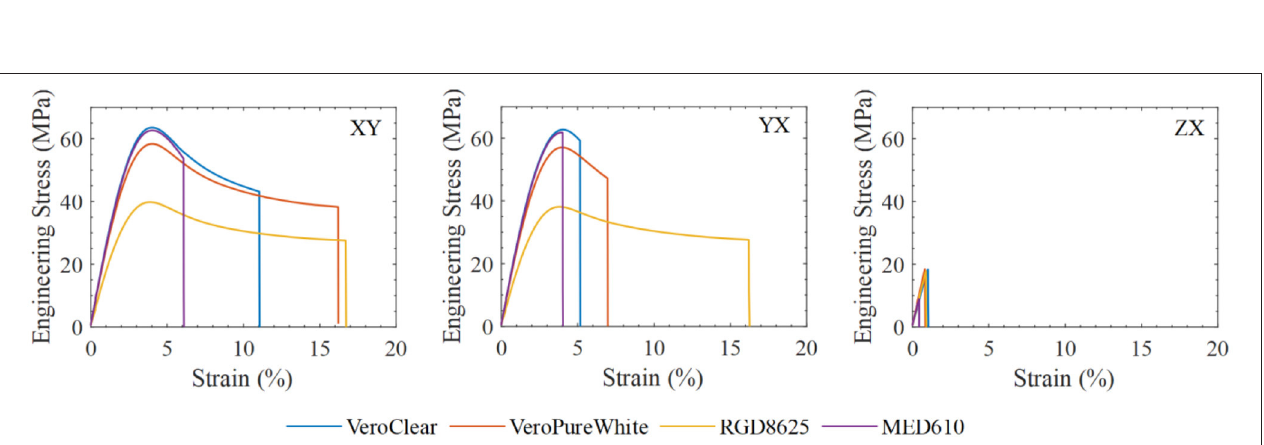
FIGURE 8 | Rigid materials. Sample comparison of the stress-strain curves of the different materials and orientation considered.